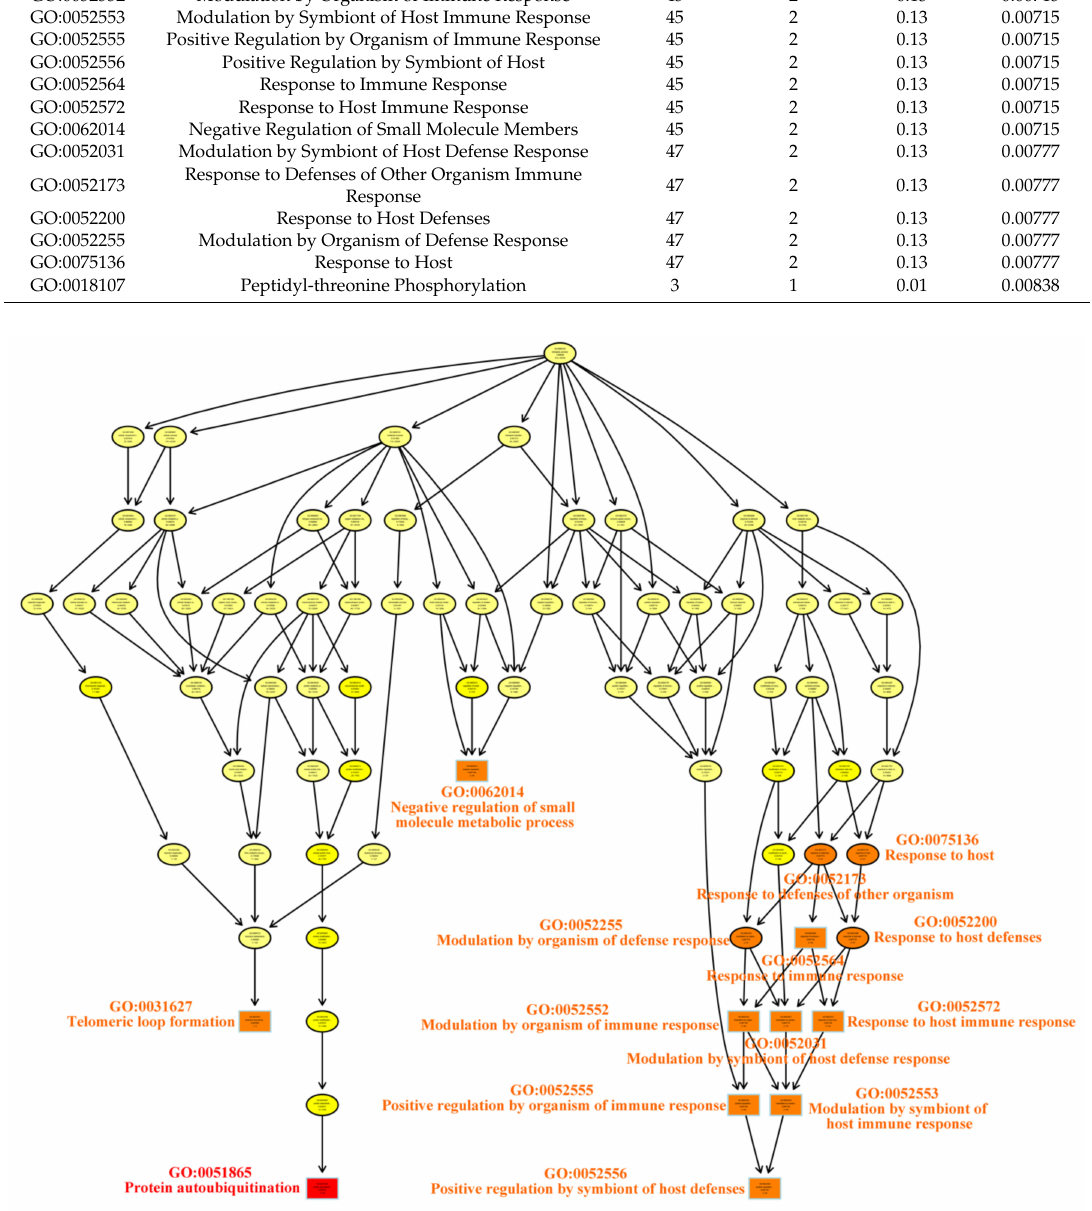
Figure 4. The enriched Gene Ontology (GO) biological process categories of genes in the green